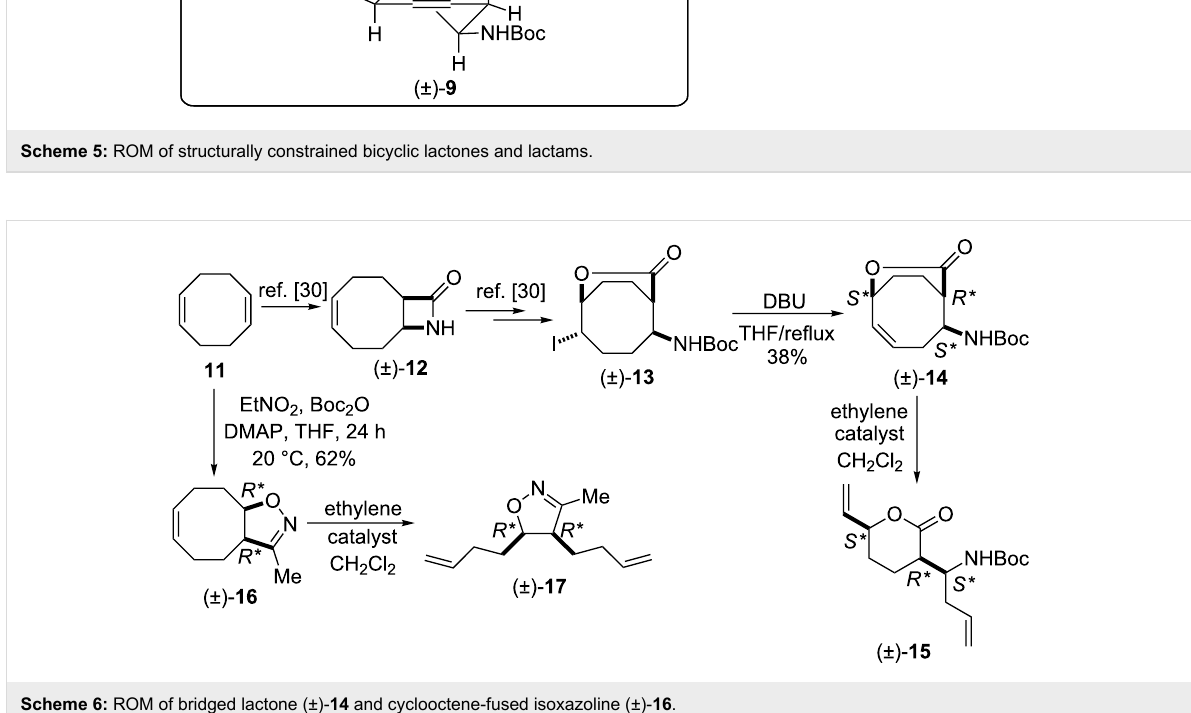
Table 4: Isolated yields for compounds formed in the ring-opening reaction of lactone (±)- 14 and isoxazoline (±)- 16 with ethylene in ROM reactions with various catalysts.